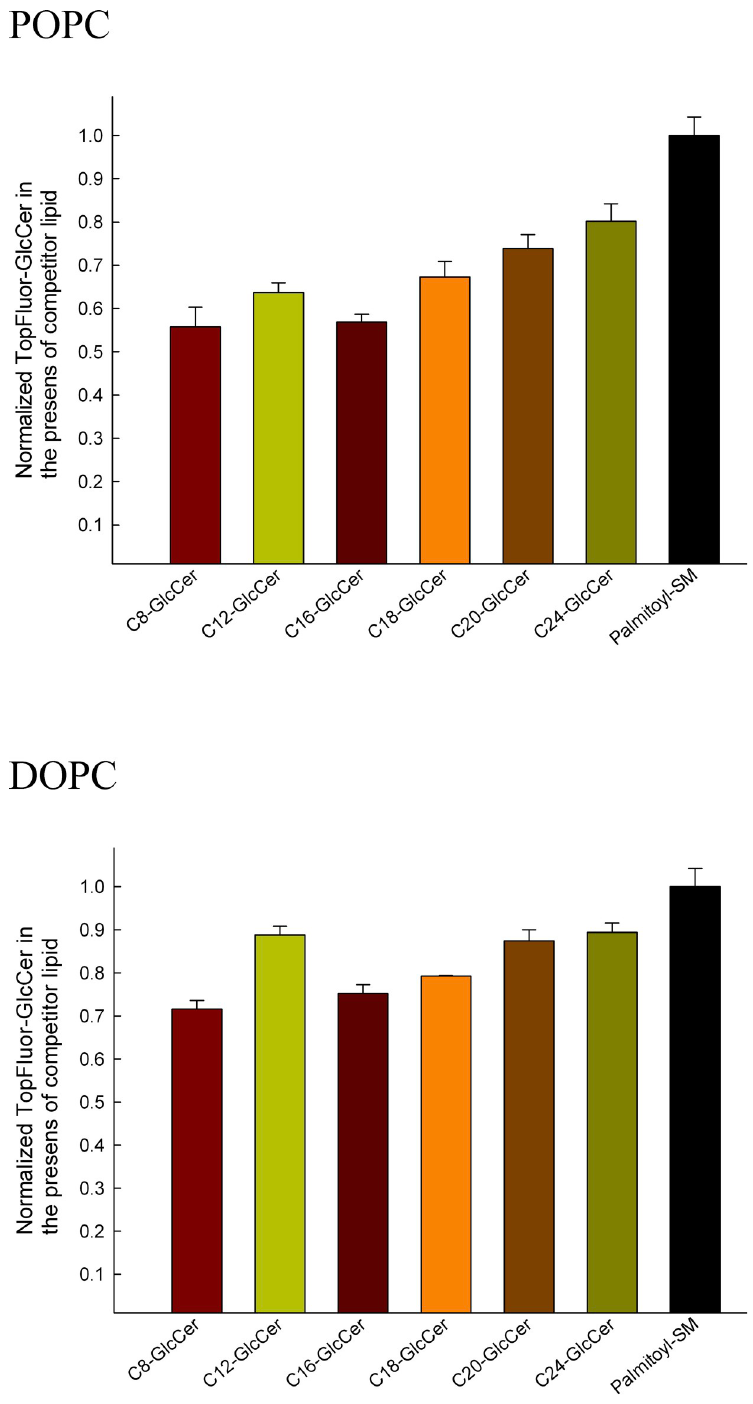
Fig 3. Competition transfer assay measured GlcCer transfer rates. Unlabeled GlcCers (1 mol%) in POPC or DOPC compete with TopFluor-GlcCer as substrates for GLTP. The rate for TopFluor-GlcCer transfer in the non-competing PSM lipid sample was normalized to 1. The data are from at least three different experiments. A statistically significant difference occurred between all fully saturated GlcCer competitor lipids and the PSM control, black bars (P = 0.001).